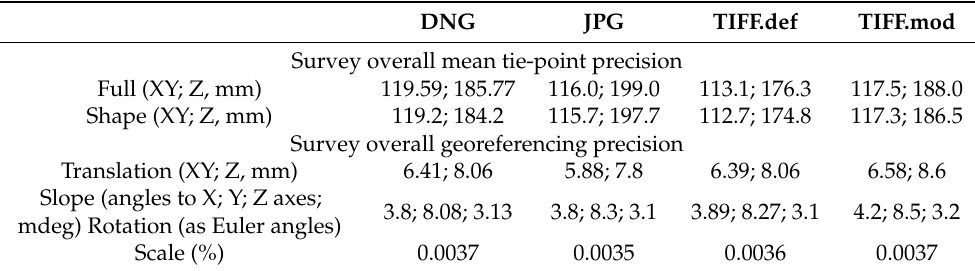
Table 4. Survey tie-point precision values extracted from the Monte Carlo analysis for each of the image sets. Full involves photogrammetric and georeferencing considerations. Shape only involves photogrammetric